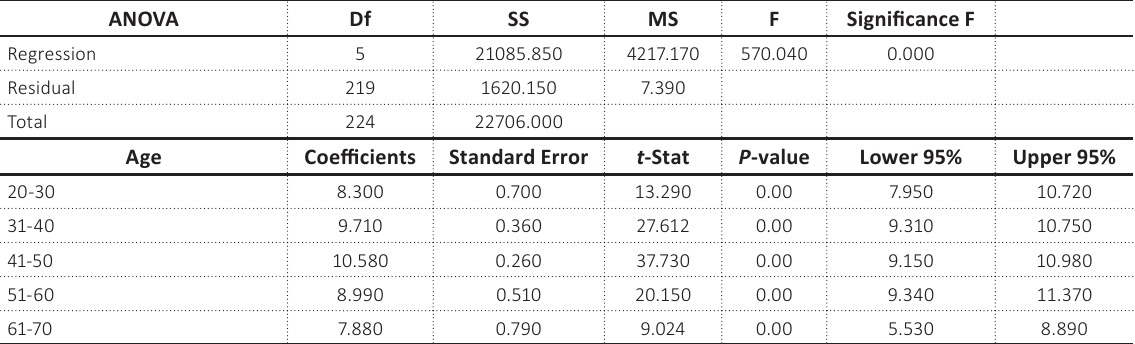
Table 3. Dispersion analysis of the equation (3) parameters ANOVA